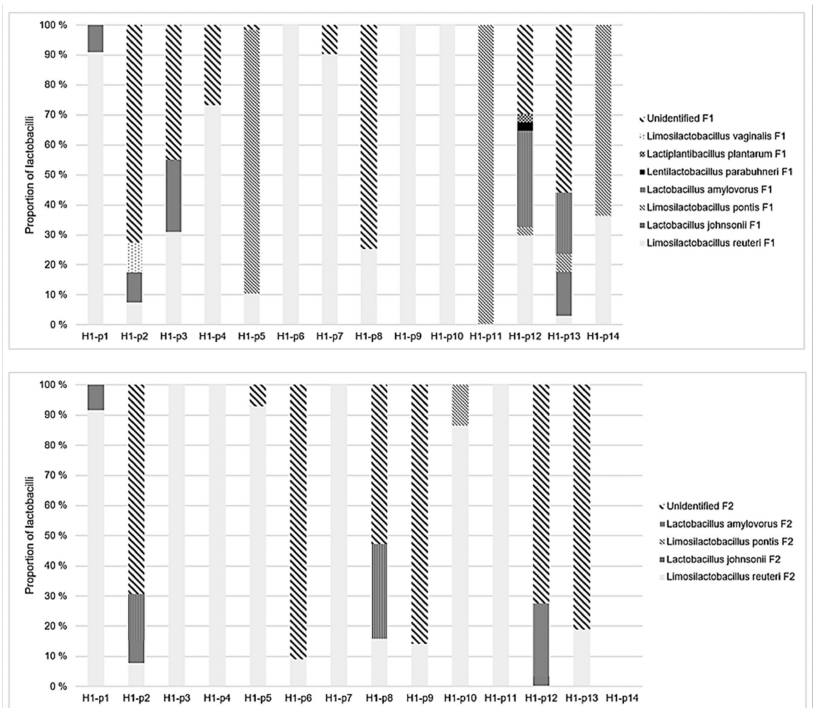
Figure 3. The proportion of lactobacilli species identified from the feces of individual pigs (14 pigs, p1–14) in the weaning unit (upper picture, fecal sampling point 1 (F1)) and fattening unit (lower picture, fecal sampling point 2 (F2)) in herd 1 (H1).